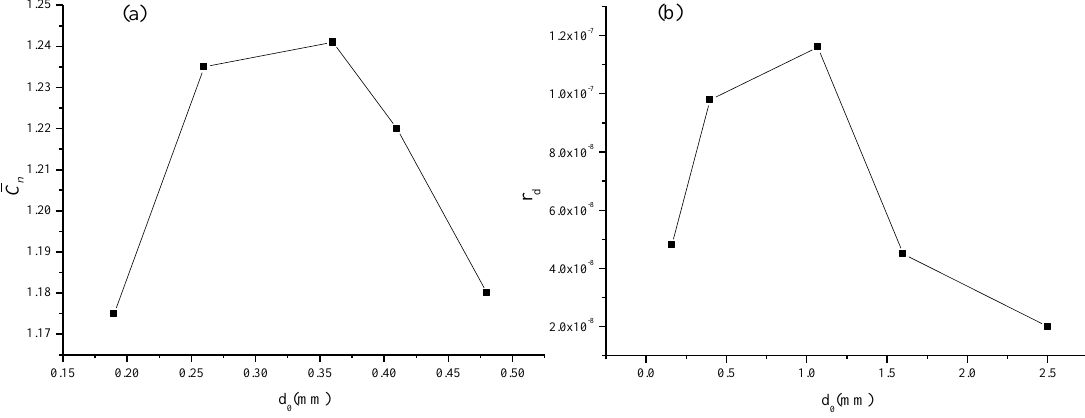
Figure 13. Response of droplets with different initial diameters under the same acoustic excitation. ( a ) Variation of C n and d 0 obtained by experiment; ( b ) Variation of r d and d 0 obtained by calculation.